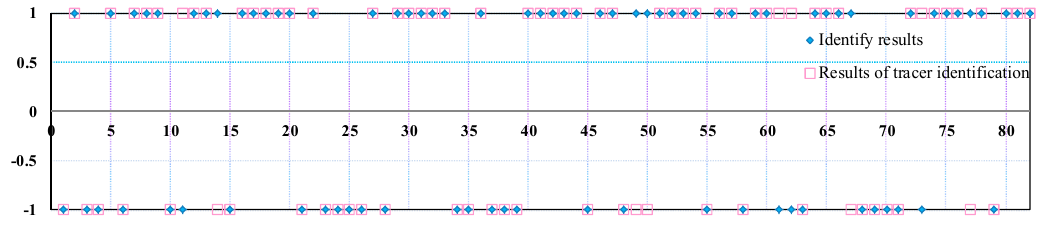
Figure 8. Comparison of identification results.